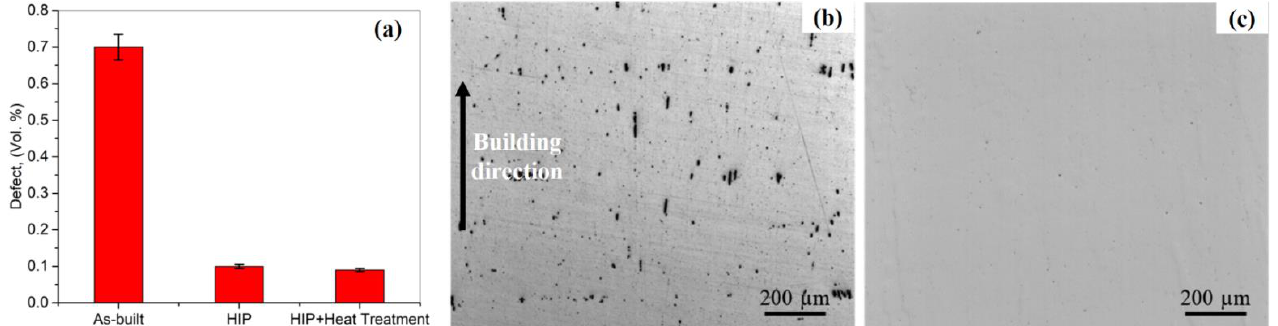
Figure 24. ( a ) Defect content in all the investigated specimens as determined by image analysis, ( b ) optical micrograph showing defects in the as-built material, and ( c ) optical micrograph showing defects elimination in the HIP product [122]; with permission from Elsevier.